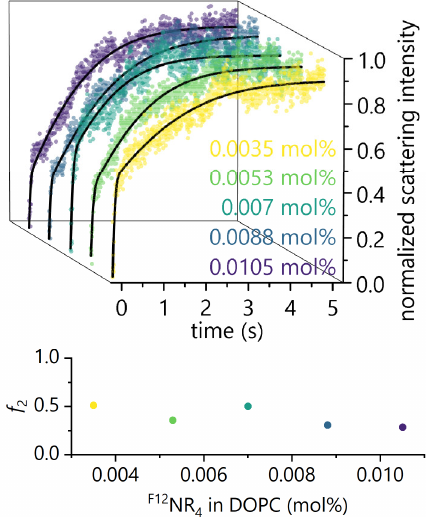
Figure 6. Paradoxically, increasing the amount of F12 NR 4 nanorings added to DOPC appears to increase the fraction, f 1 , deflating with the kinetics of the bare lipid bilayer, i.e., more channel components added yielded fewer channel-containing vesicles. The stopped-flow light scattering traces of DOPC vesicles with increasing fractions of F12 NR 4 nanorings were averaged and normalized, as suggested by Itoh et al. [10] (https://doi.org/10.5061/dryad.h18931zq1). As the main text outlines, the scattering traces are incompatible with a homogeneous ensemble of vesicles, each containing F12 NC 4 channels with the alleged extreme water permeability (see Figure 2). To that effect, we fit the traces assuming two vesicle populations [14]: one without channels indicating background lipid permeability ( f 1 ) and one with faster kinetics ( f 2 ). The fit reports the magnitude of both fractions. The relative contribution of the fast population ( f 2 ) is plotted against the fraction of F12 NR 4 nanorings added to DOPC. We find no positive correlation between f 2 and the amount of added F12 NR 4 nanorings. This means that increasing the amount of F12 NR 4 added to lipids does not increase the fraction of vesicles containing functional F12 NC 4